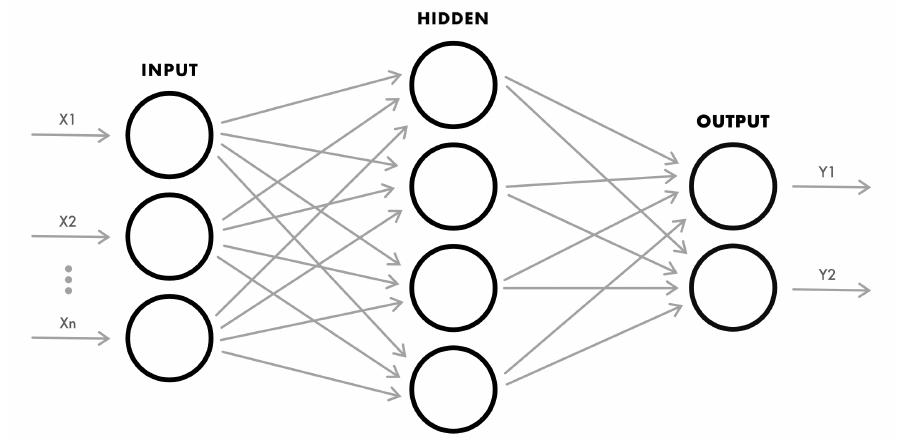
Figure 3. Artificial Neural Network with a demonstration of process parameters and